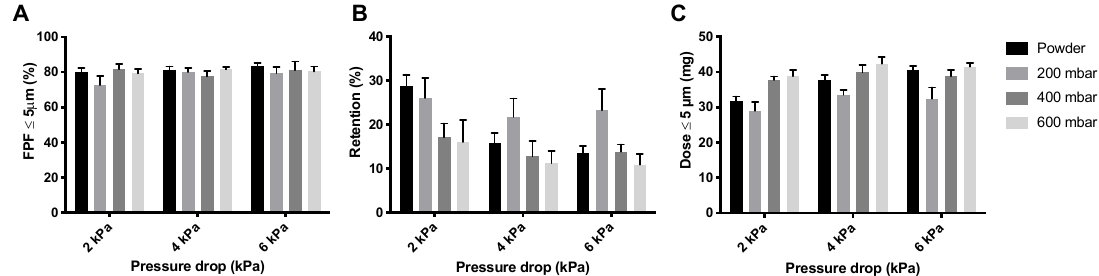
Figure 6. The effect of vacuum pressure on the dispersion from the Cyclops ® inhaler of 55 mg isoniazid. Panel ( A ) shows the FPFs for the loose powder and the three different pellets, panel ( B ) shows the retention, and panel ( C ) shows the FPD (average ± SD, n = 5). The FPD is calculated by multiplying the FPF with the emitted dose (=FPF × (1 − retention)).